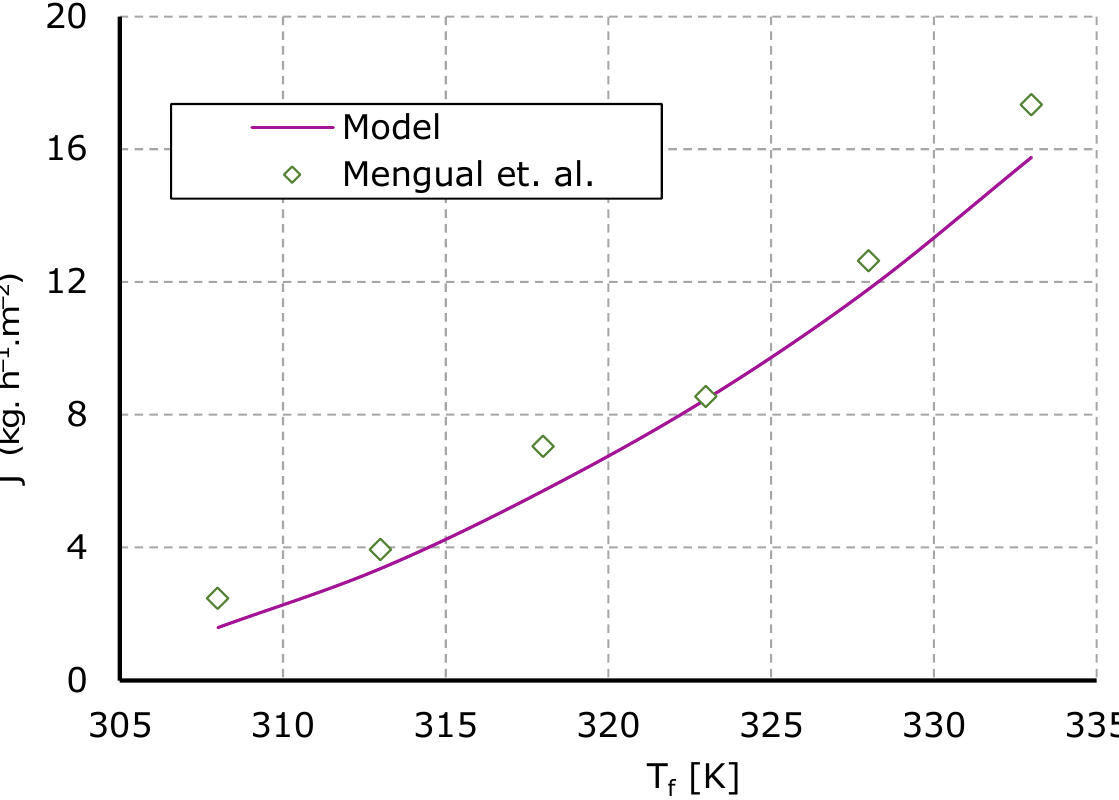
Figure 11. Validation of empirical model considered for VMD.